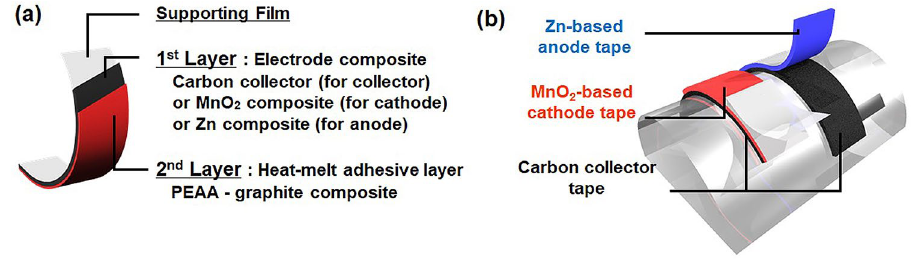
Figure 1. Illustration of the layered structure of transferable flexible battery components ( a ) and its application to the curved surface ( b ). These illustrations were designed with the free software POV-Ray for windows— version